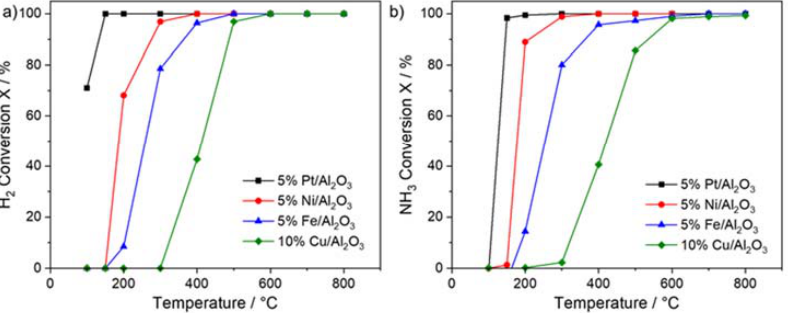
Figure 5. ( a ) Hydrogen and ( b ) ammonia conversion vs. reaction temperature for different transition metal catalysts, the platinum ‐ based catalyst is shown for comparison, WHSV = 600 L/g h. The NO x concentrations observed for the tested transition metal catalysts are much lower compared to the platinum catalyst (see Figure 6a). The trend however is the same as for the noble metal catalysts. Once the reaction temperature is sufficiently high for catalytic ammonia combustion, NO x can be detected at the reactor outlet. The NO x concentrations and selectivities observed for the transition metal-based catalysts increase with reaction temperature and then stagnate at temperatures of 500 °C and above.